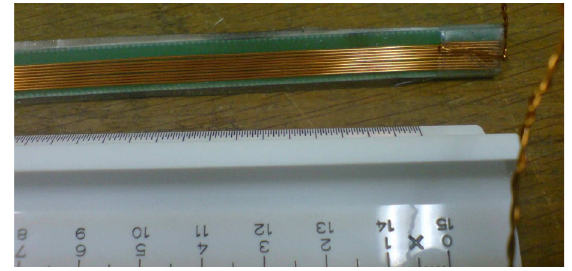
FIG. 10. (Color) Detail of one of the probe coils fabricated for the measurements.